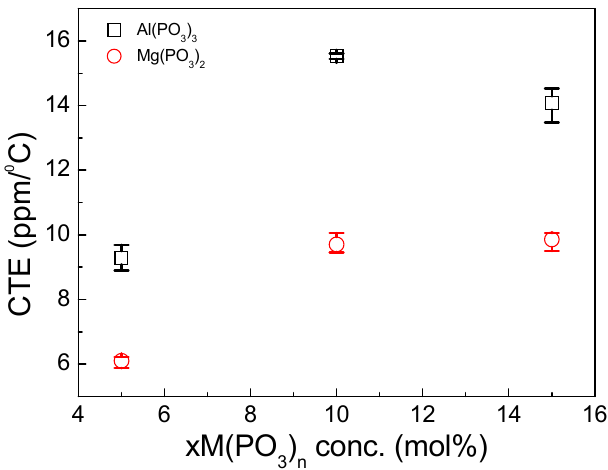
Figure 5. Variation of coefficient of thermal expansion (CTE) in (70-x)V 2 O 5 -5ZnO-22BaO-3B 2 O 3 - xM(PO 3 ) n (mol%) (where M = Al, Mg, n = 3, 2, respectively, mol%) glass as a function of metaphos- phate concentration.